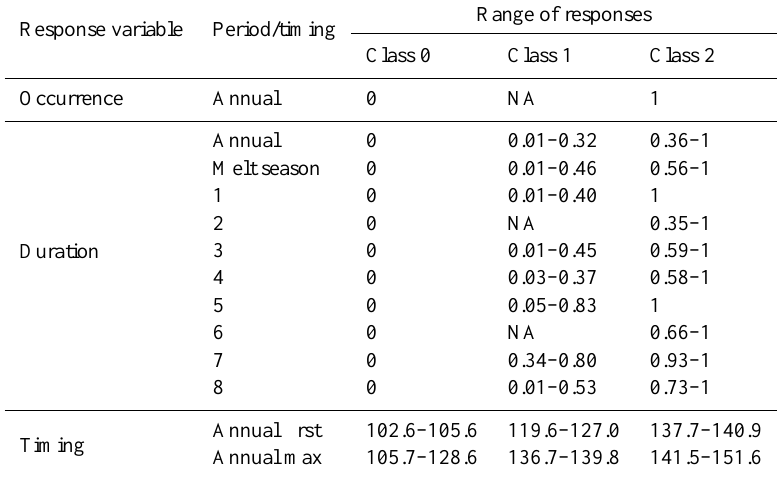
Table 3. Range of groundwater responses for the response variables modeled using ordinal logistic regression (i.e. for modeling, the measured response values were replaced with the class values of 0, 1, or 2). The response variables are the occurrence of response over the annual period; the duration of response over the annual period, melt period, and periods 1 through 8; and the timing of first and maximum responses over the annual period. Units for duration are the fractional portion of the period. Units for timing are decimal day of the